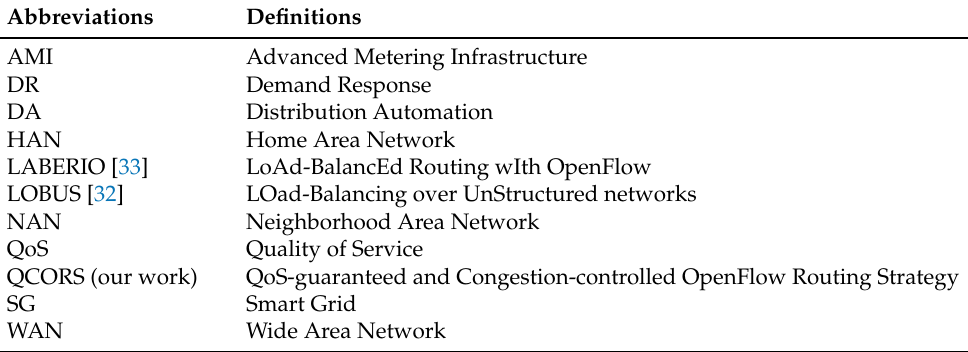
Table 1. The abbreviations and the corresponding